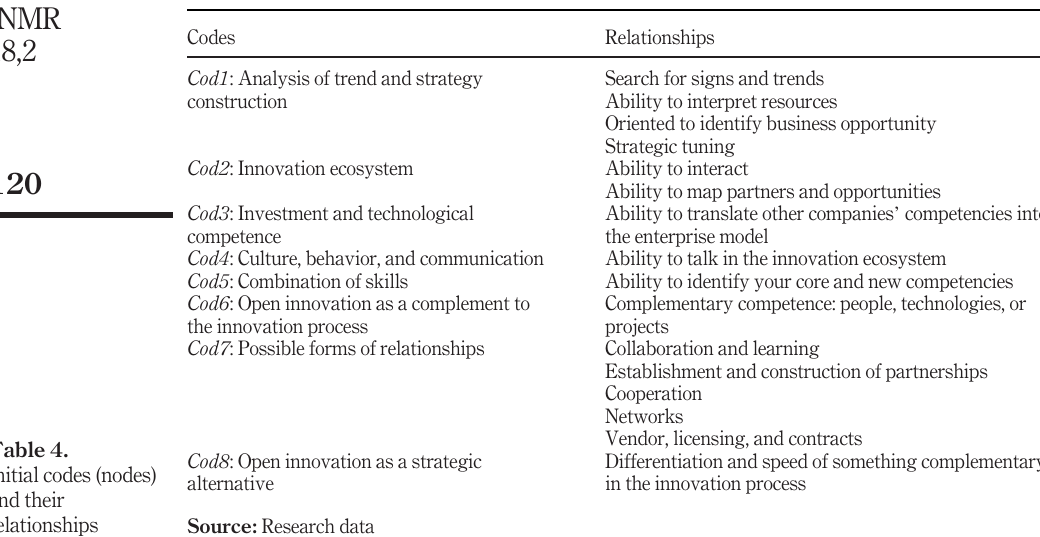
Table 4. Initial codes (nodes) and their